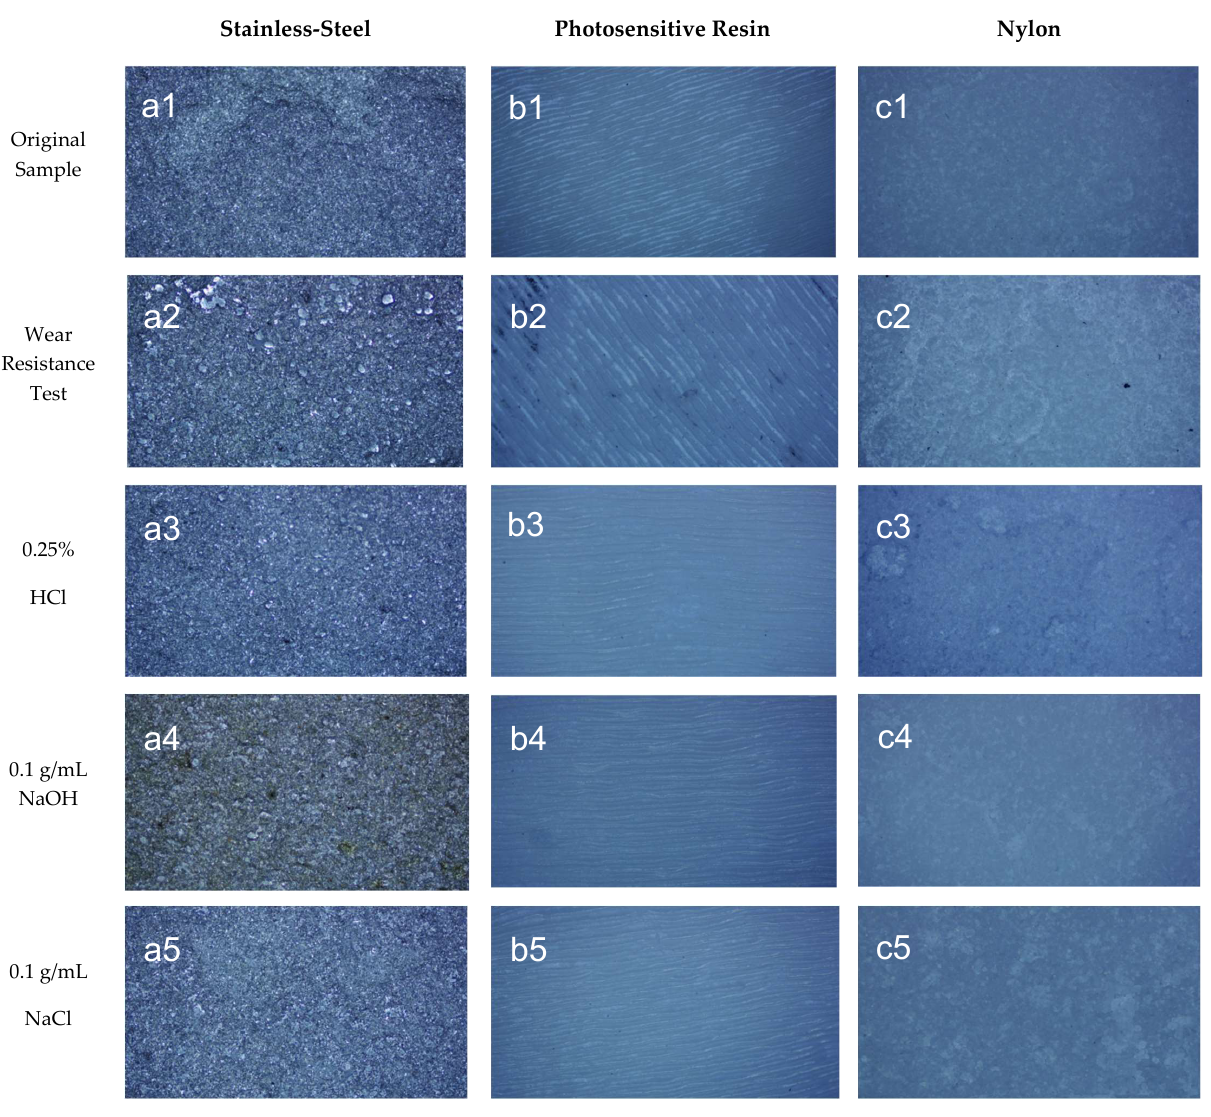
Figure 7. (a1-c1) Surface morphologies of stainless steel, photosensitive resin, and nylon; (a2-c2) Figure 7. ( a1 – c1 ) Surface morphologies of stainless steel, photosensitive resin, and nylon; ( a2 – c2 ) Ma- Material surface morphologies after wear resistance tests; (a3-c3) Material surface morphologies af- terial surface morphologies after wear resistance tests; ( a3 – c3 ) Material surface morphologies after ter 0.25%HCl dilute solution corrosion test; (a4-c4) Material surface morphologies after 0.1 g/mL 0.25%HCl dilute solution corrosion test; ( a4 – c4 ) Material surface morphologies after 0.1 g/mL NaOH NaOH dilute solution corrosion test; (a5-c5) Material surface morphologies after 0.1 g/mL NaCI di- dilute solution corrosion test; ( a5 – c5 ) Material surface morphologies after 0.1 g/mL NaCI dilute lute solution corrosion test. solution corrosion